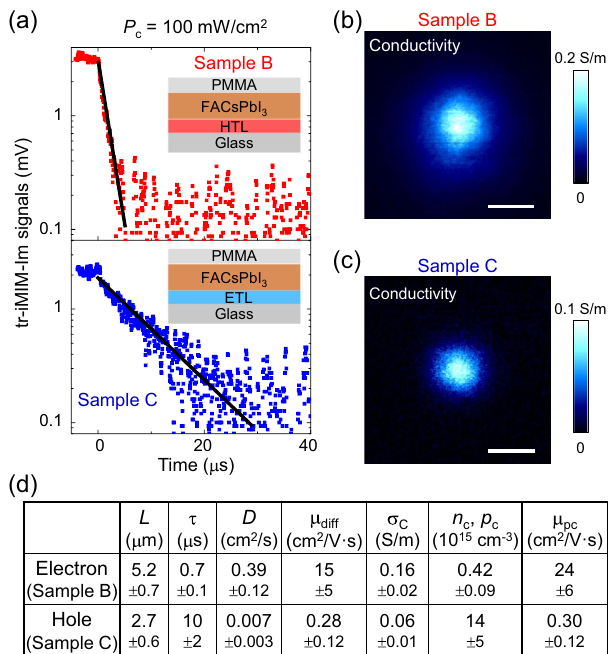
Fig. 3 Results and analysis on HTL/ETL samples. a tr-iMIM signals on the HTL Sample B (upper panel) and ETL Sample C (lower panel). The layer structures of each sample are illustrated in the insets. b Diffusion maps of Sample B and c Sample C under the illumination of 446-nm laser at P = 100 mW/cm 2 . Scale bars are 10 μ m. d Tabulated parameters for the C calculation of electron/hole mobility values by two methods, i.e., μ diff from the Einstein relation and μ pc from photoconductivity